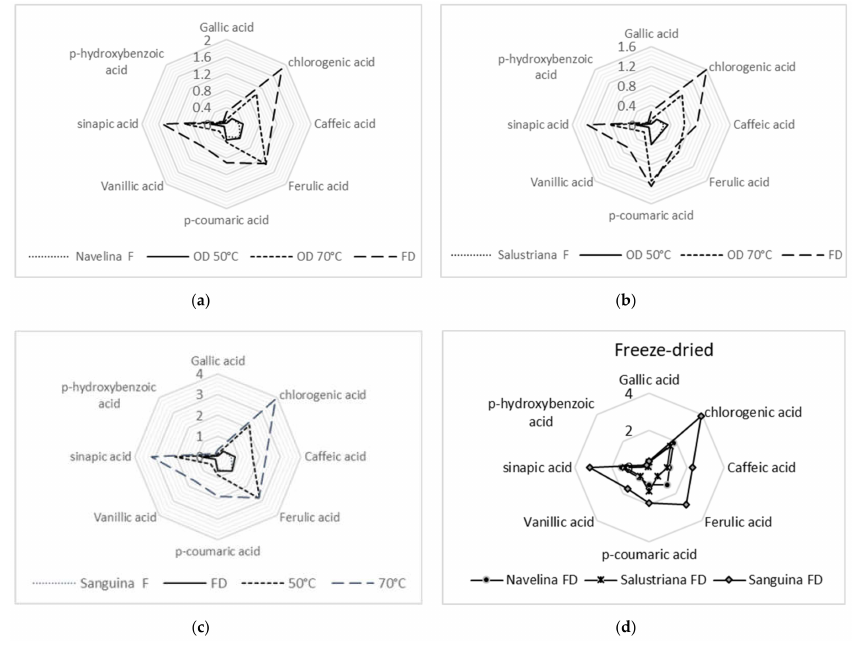
Figure 3. Phenolic acids (mg g − 1 DW) of Navelina ( a ), Salustriana ( b ), and Sanguina peels ( c ), fresh (F), after freeze-drying (FD), and after oven-drying (OD-50 ◦ C, OD-70 ◦ C). ( d ) shows the comparison between the three FD orange